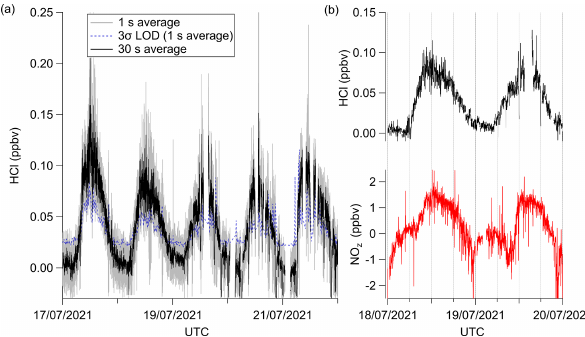
Figure 9. Excerpted field data from the summer OSCA 2021 cam- paign. (a) Averaged time series during the final week of measure- ments, in which gray represents 1s data collection frequency, the dashed blue line represents the 1Hz 3 σ limit of detection, and the black trace represents 30s averages of these same HCl data. (b) Comparison of HCl time series (top) and concurrent NO z time series, with both averaged to 1min. Gaps in data result from addi- tions of high-concentration HCl standards that do not reflect ambi- ent values. The increased noise in the data around these time periods is likely due to inlet effects following the HCl